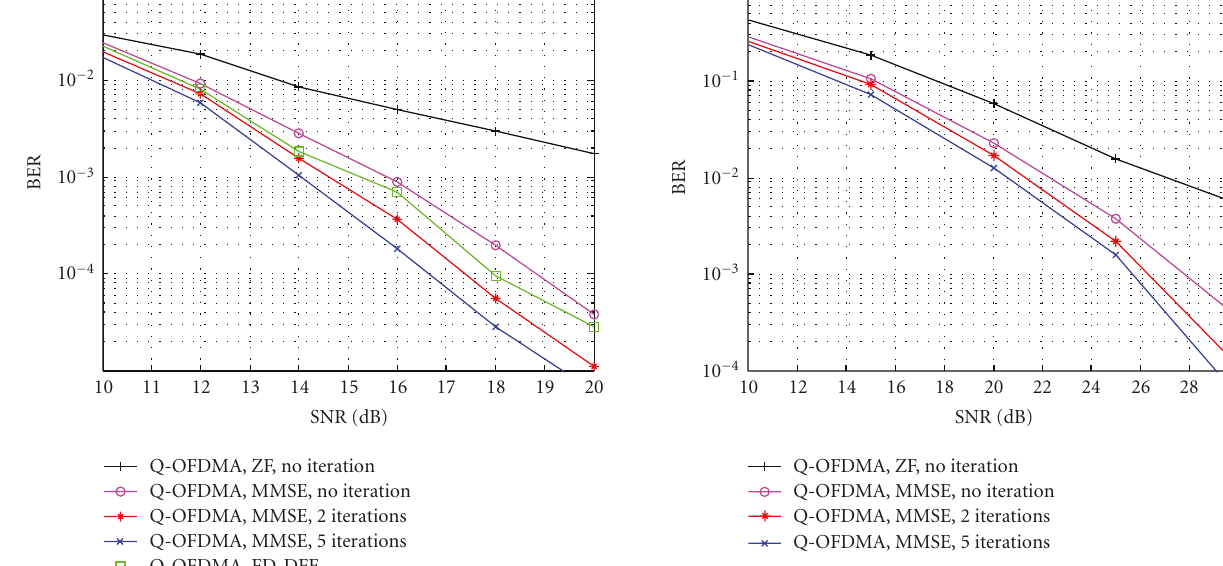
Figure 6: BER performance comparison between Q-OFDMA systems with di ff erent receivers in CM2 channel model, with QPSK modulation.